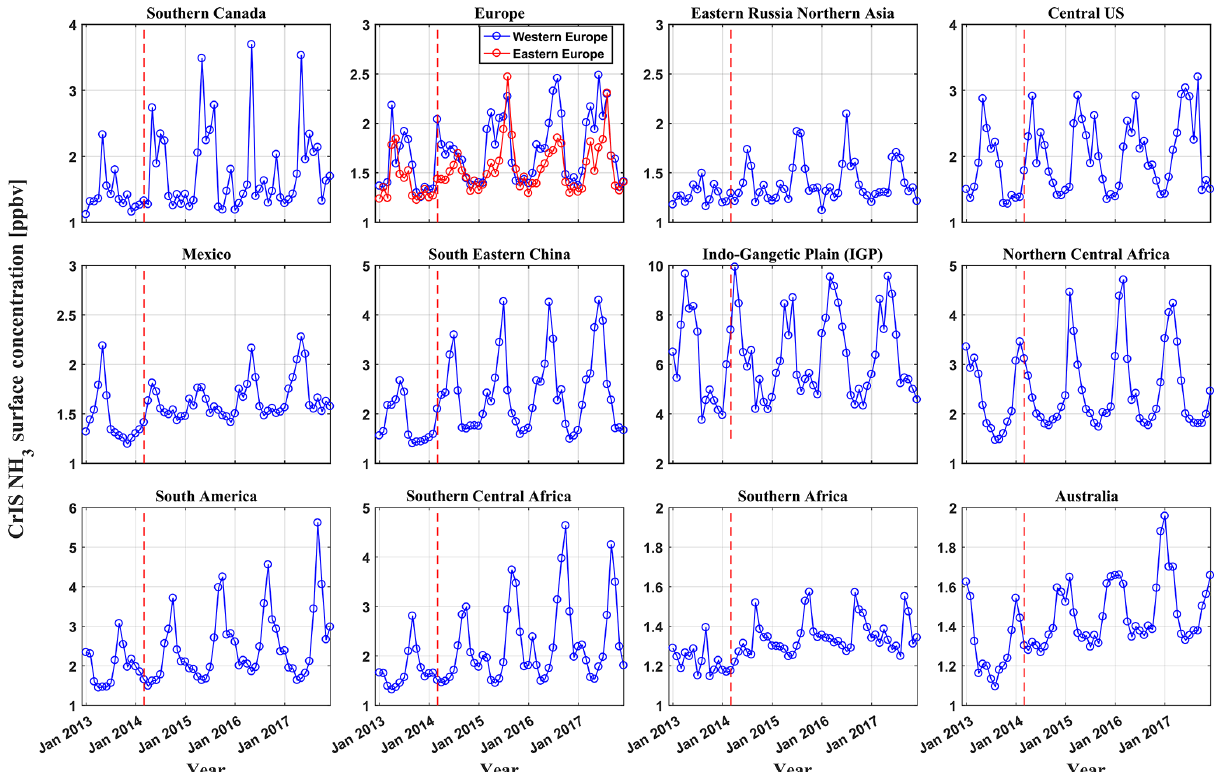
Figure 10. Time series of the CrIS-retrieved surface ammonia volume mixing ratios over the regions shown in Fig. 9. The red vertical dotted line indicates where there was a change in the product used for the input atmospheric state for the CFPR ammonia